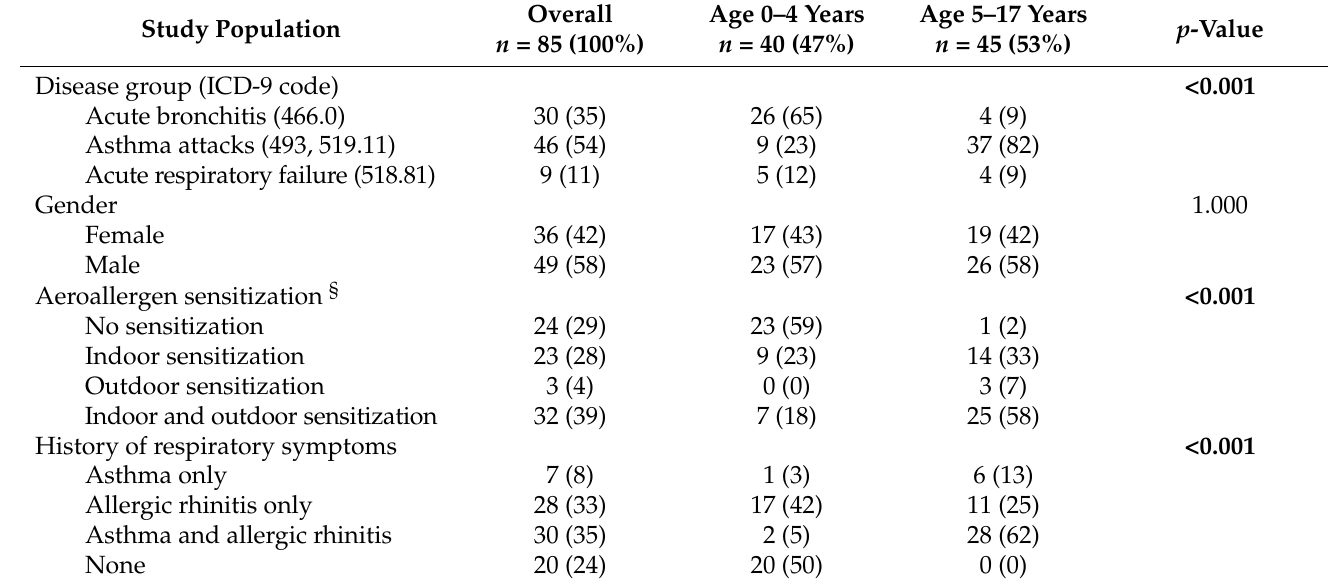
Table 1. Distribution of the 85 admissions for asthma-like symptoms by age group. Significant effects are in